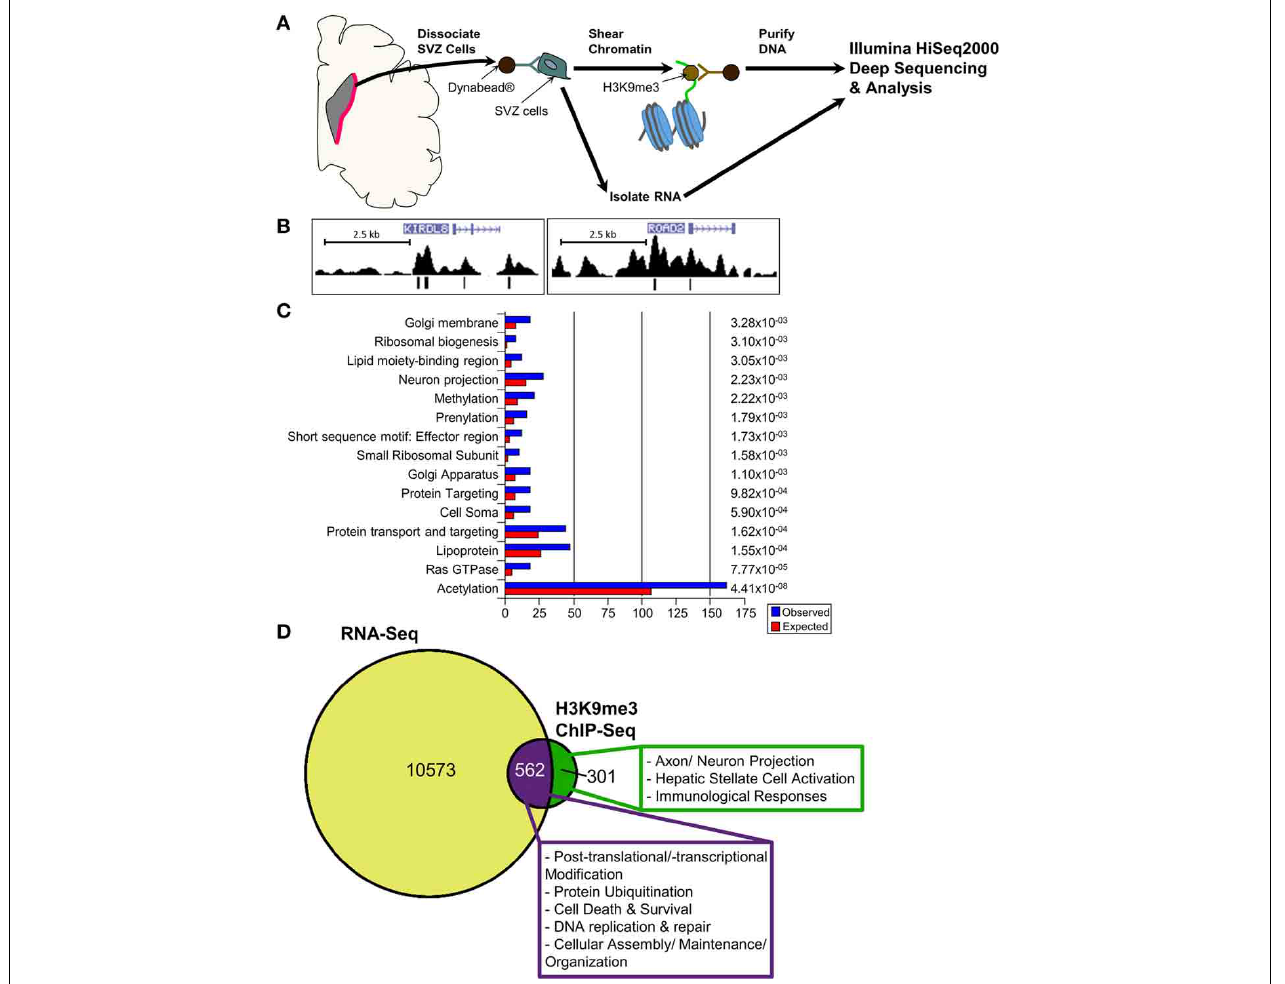
FIGURE 4 | ChIP-Seq and RNA-Seq analyses for in vivo SVZ cells from baboon brain. (A) Scheme displays purification of in vivo baboon SVZ cells and processing for ChIP-Seq with H3K9me3 antibody and for RNA-Seq. (B) Peak views of representative H3K9me3 enriched genes KIRDL8 and ROAD2. [ ] within the genes indicate the transcript direction and strand sense. H3K9me3 signal is “mapped read density” after normalization to unmodified H3—vertical bars in peak track annotate significant reads within the density plot. The H3K9me3 peaks were called at FDR0.05, which is derived from a comparison of mapped read enrichment relative to a local